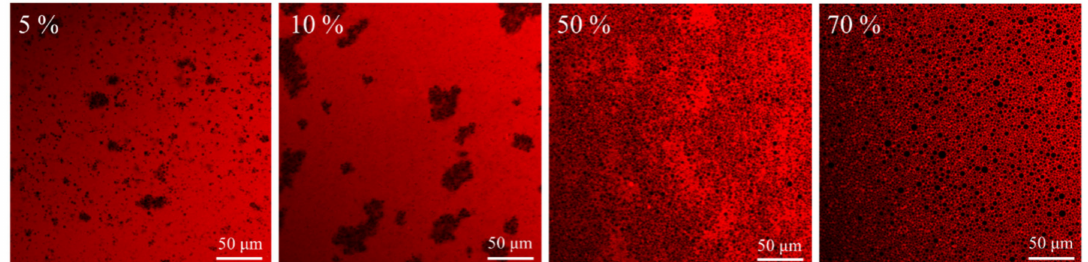
Figure 8. Confocal fluorescence images of n-hexadecane hydrogel emulsions with different oil mass fractions were stabilized by a concentration of 0.5 M gelator and taken after storage at 20 ◦ C for 3